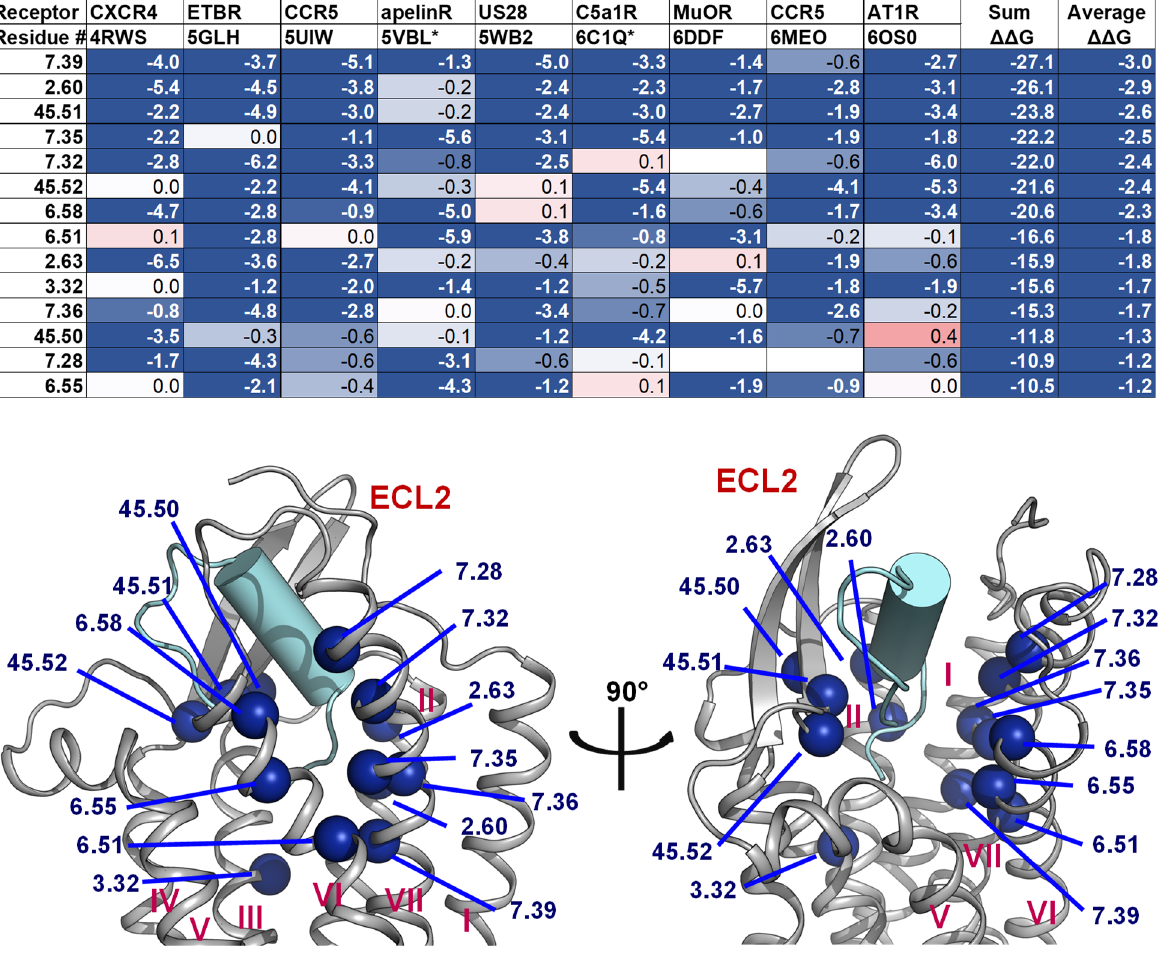
Figure 7. Residues with the strongest interactions according to the average computed ∆∆ G suggest the common binding pocket of peptide ligands. ( Upper ) A table shows a list of residues with the top average computed ∆∆ G values. The residues are numbered according on the Ballesteros-Weinstein numbering scheme [69]. For each residue position, the ∆∆ G values are colored in the scale from − 1 and less (blue) to 0 (white) to 1 and above (red). The absence of the ∆∆ G values indicates that the corresponding residues do not interact with the peptide ligands. Two final columns of the table contain the sum and the average ∆∆ G values across nine peptide-class A GPCR structures, respectively. The residue list is sorted in their ascending average ∆∆ G order. ( Lower ) Front and side view of the common peptide binding pocket towards the core of nine class A GPCR structures. The top residues in the upper table are mapped on the ET-1/ETB structure (PDB ID: 5GLH) [55]. The important residues for peptide engagement across eight class A GPCRs are marked by blue spheres. The peptide ligand ET-1 is shown as a cyan cylinder with two unstructured extended regions.